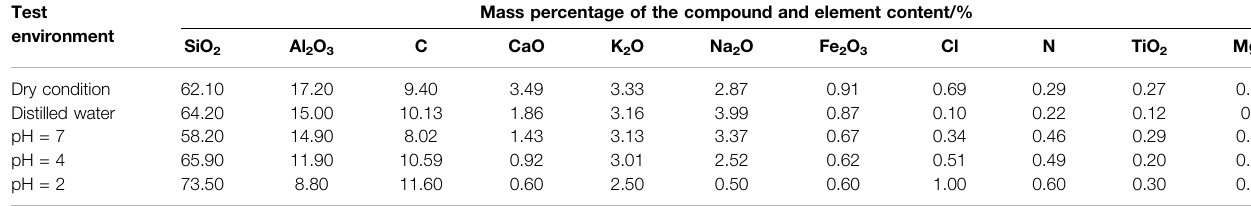
TABLE 4 | Contents of the main compounds and chemical elements in granite before and after the action of different hydro-chemical solutions. Test